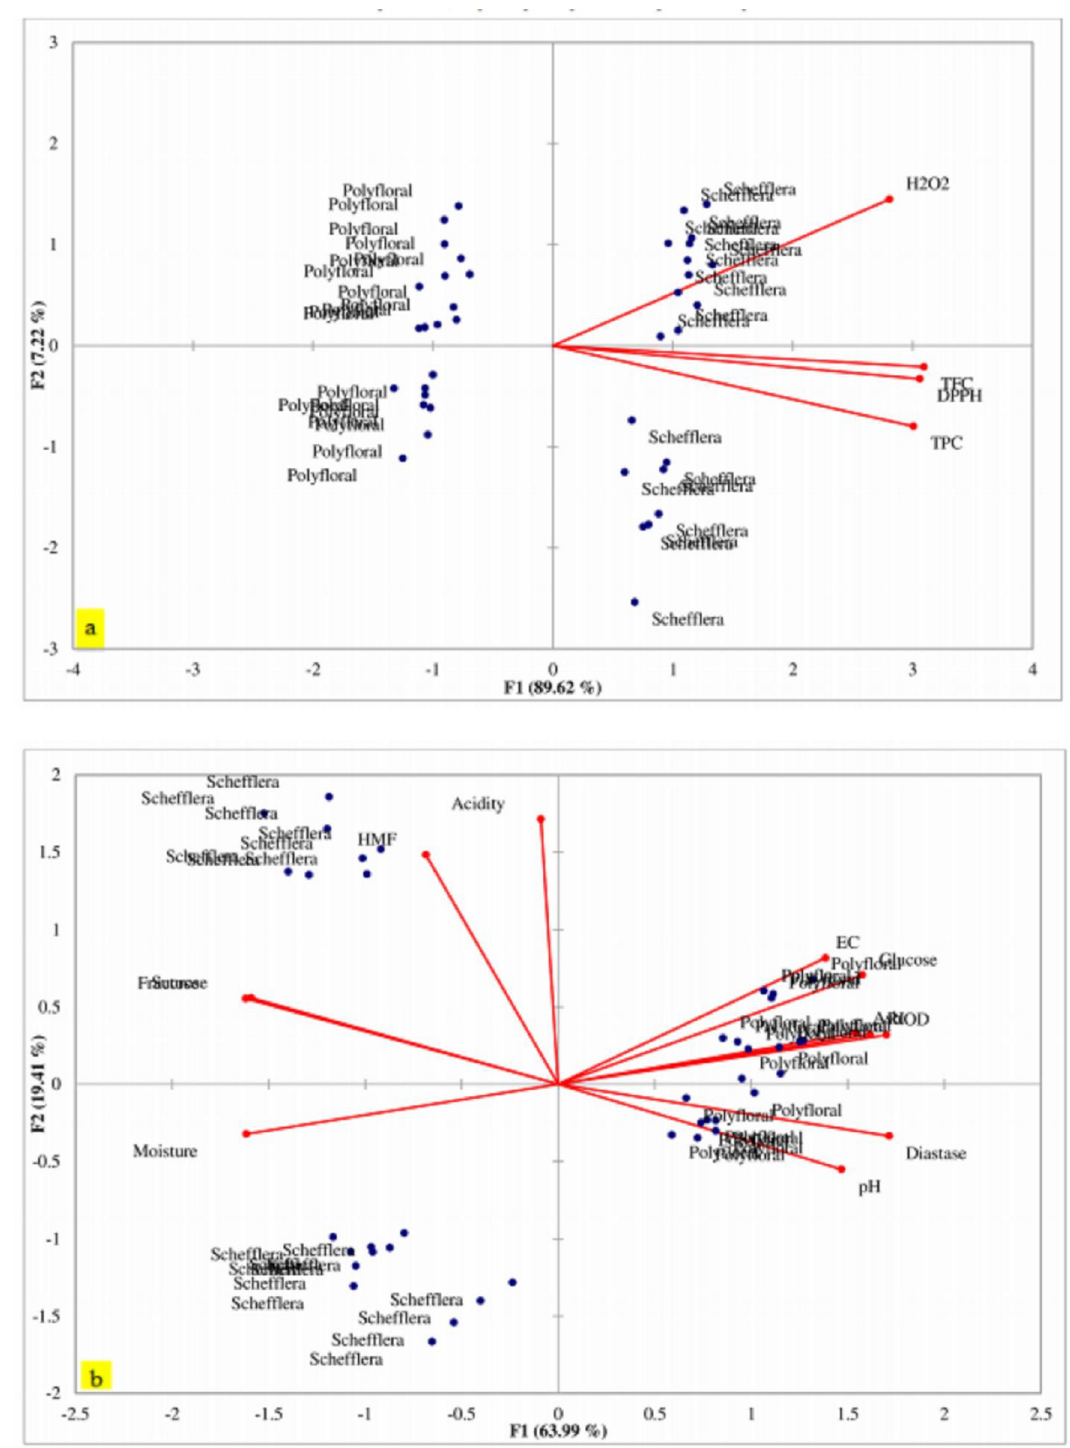
Fig 3. Principal component analysis predictive biplots of botanical origin over antioxidant (a) and physicochemical (b) properties. The degree of proximity between variables and the narrower angle between diagonal lines indicated a strong association. TPC = Total phenolic content; TFC = Total flavonoid content; DPPH = 1, 1-diphenyl-2-picrylhydrazyl scavenging activity; H 2 O 2 ; hydrogen peroxide scavenging activity; RI = refractive index; OD = optical density; HMF = hydroxymethylfurfural; EC = Electrical